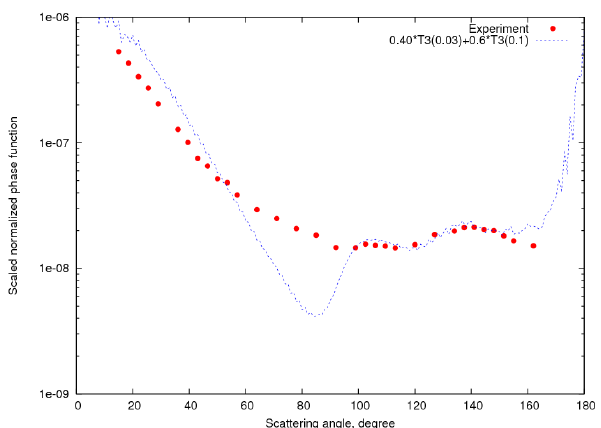
Fig. 6. Same as Fig. 5 but for the weighted habit mixture model 2 (0.3 · C+0.7 · Sphere). 772